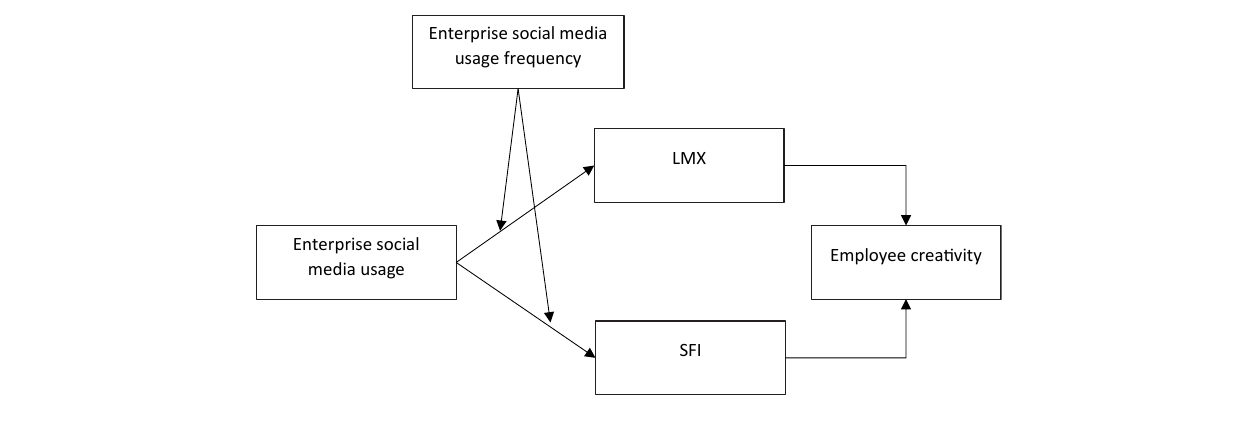
FIGURE 1 | Proposed theoretical